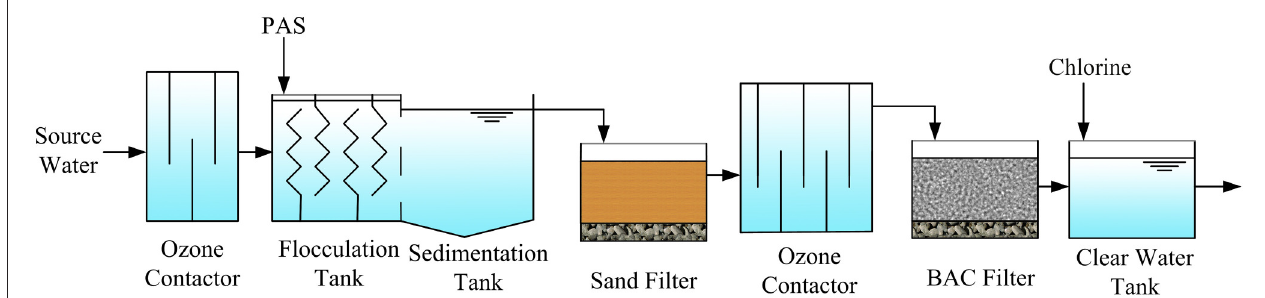
FIGURE 1 | Schematic diagram of the drinking water treatment plant (PAS, polyaluminium